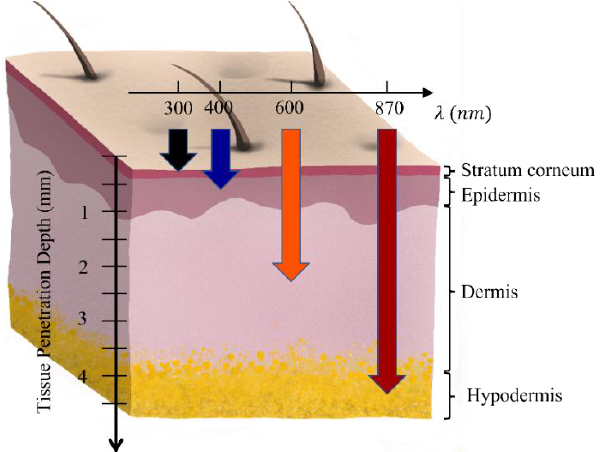
Figure 1. Skin penetration depth of light with different wavelengths [11,12].